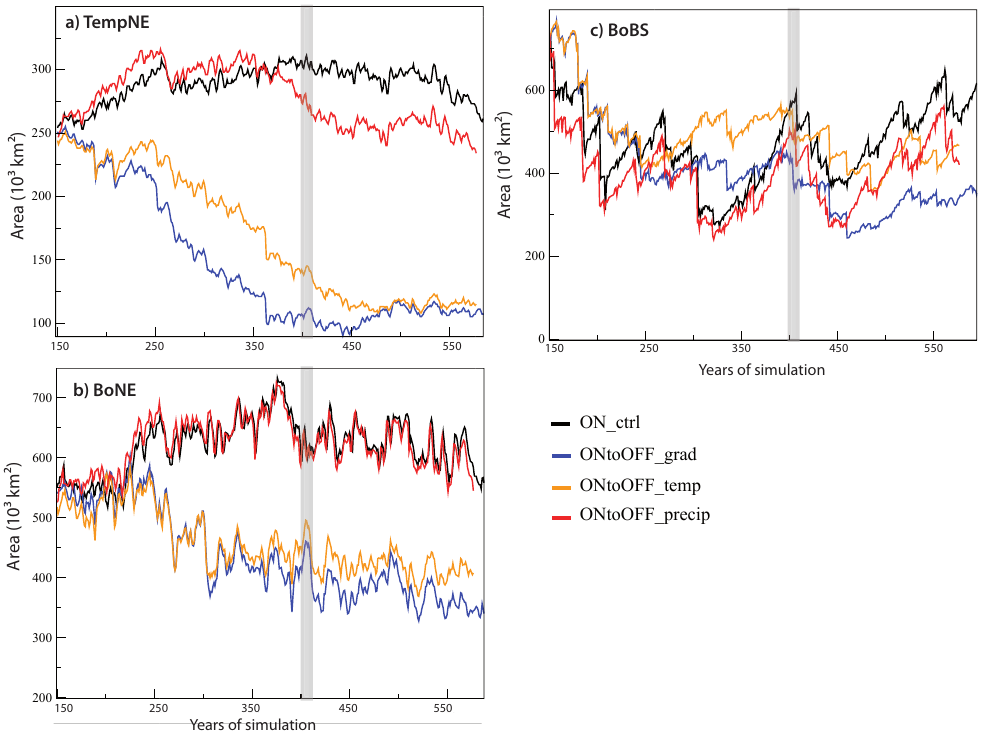
Fig. 13. Area of Western Europe (lat=32/60 ◦ , lon= − 15/20 ◦ ) occupied by (a) Temperate needleleaf evergreen; (b) Boreal needleleaf ev- ergreen; (c) Boreal broadleaf summergreen trees in ON ctrl (black), ONtoOFF grad (blue), ONtoOFF precip (red) and ONtoOFF temp (orange). The vertical grey bars indicate when the AMOC is fully collapsed in ONtoOFF